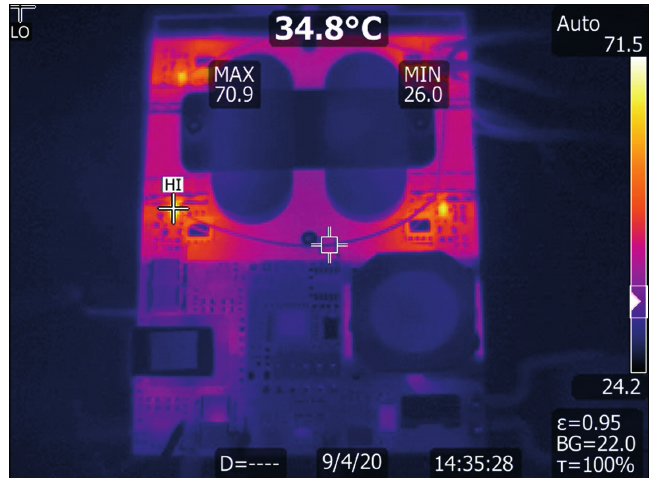
Figure 15. Thermal image of the converter at steady-state and P o = 1.5kW with forced cooling. The hottest component (71°C) is the gate driver for the synchronous rectifier switches, which each dissipate around